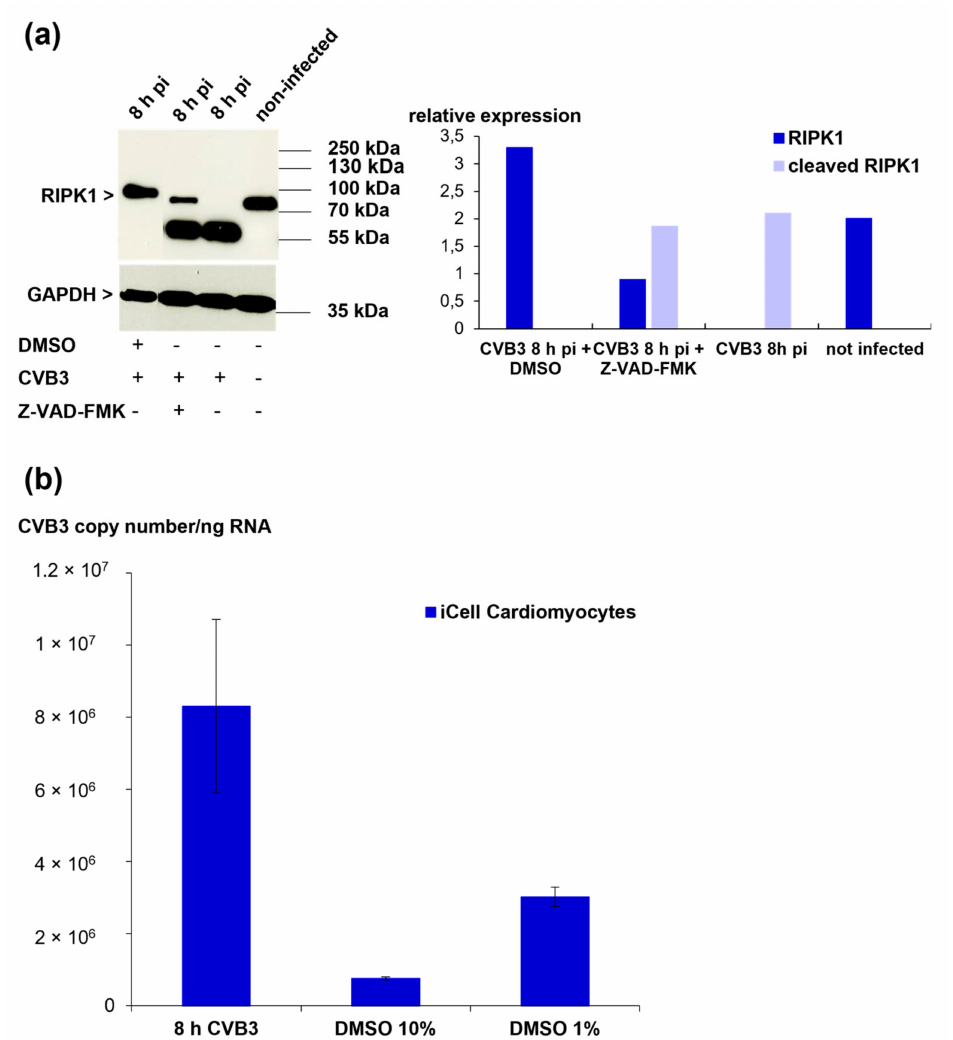
Figure 8. ( a ) Western blot analysis of RIPK1 expression in CVB3-infected iCell ® Cardiomyocytes eight hours pi (MOI 10) after pre-treatment with DMSO or Z-VAD-FMK (pan-caspase inhibitor) (left panel). Densitometric analysis is shown in the right panel. Data were normalized to GAPDH. ( b ) Quantification of viral load after DMSO treatment. iCell ® Cardiomyocytes were pre-incubated with DMSO at different concentrations for one hour before CVB3